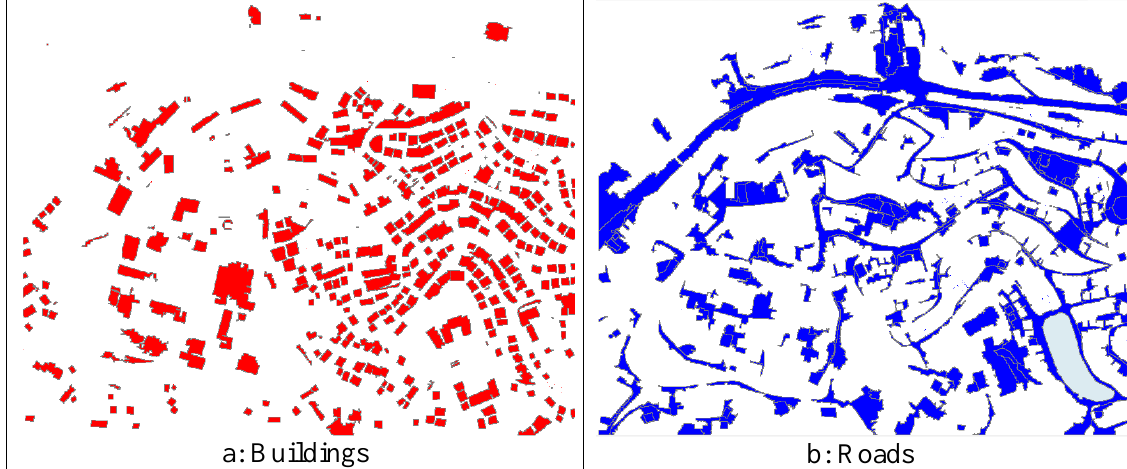
Figure 4. Vector results of object-based classification of building (a) and road network (b) from Ikonos (2008) image